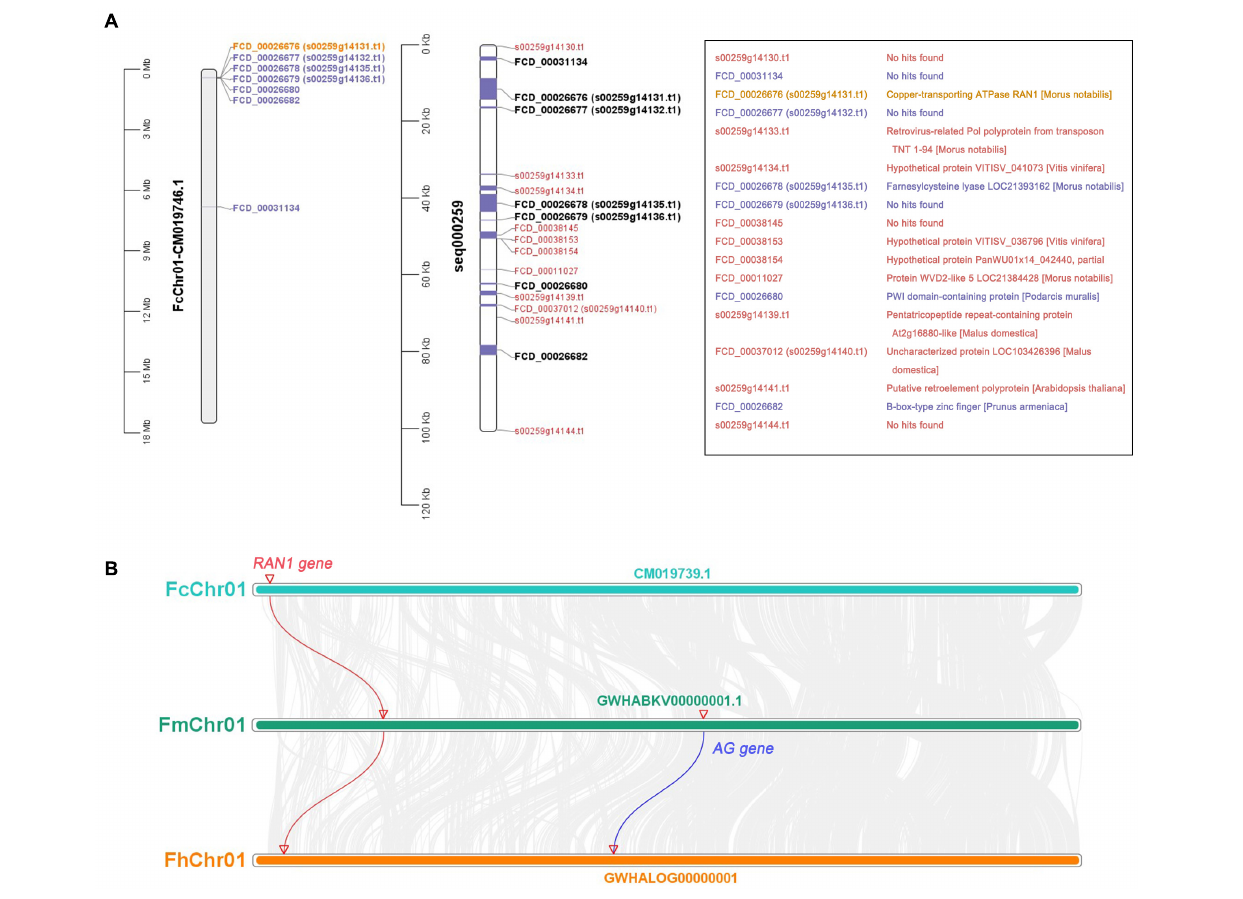
FIGURE 7 | Gene annotation of 0–100 kb in seq000259 scaffold and chromosome collinearity analysis. (A) Position of genes on FcChr01 of cv. Dottato (left) and seq000259 scaffold of cv. Horaishi (middle). Orange, purple, and black genes can be matched to Chr01; red genes lack chromosome location information. Gene annotation information is shown in the box (right). (B) Chromosome collinearity of RAN1 and AG from three Ficus species ( F. carica , F. microcarpa , and F. hispida